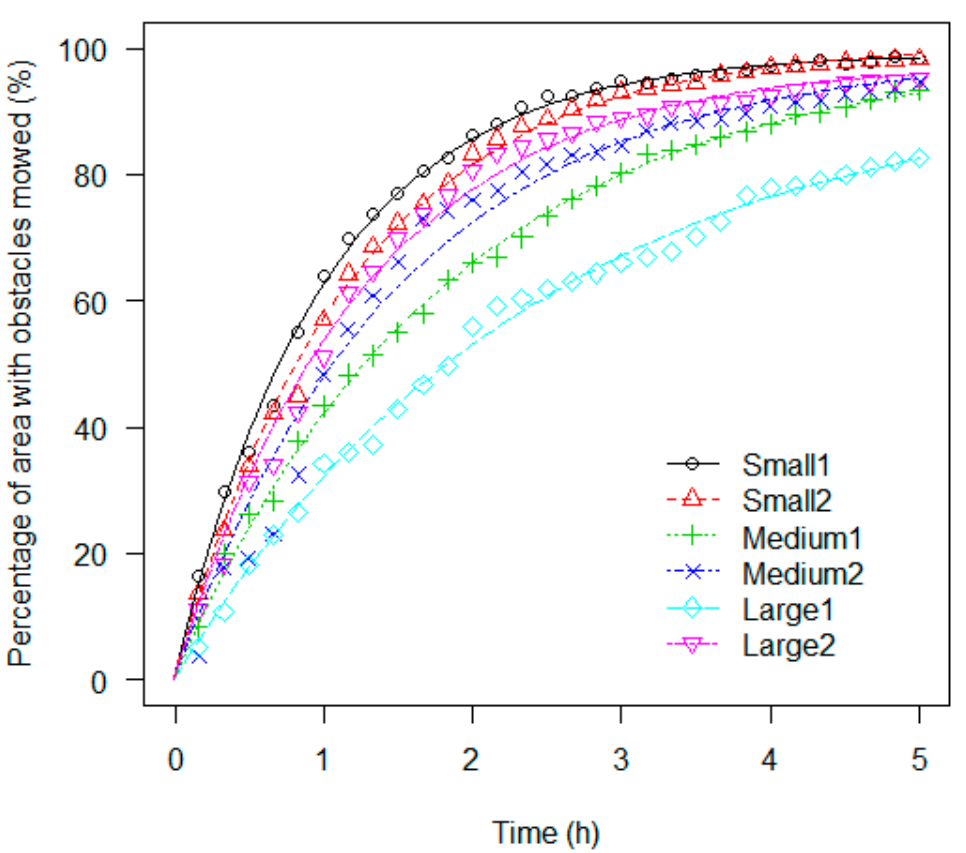
Figure 5. Fitted asymptotic regression curves with average points of the percentage of area with obstacles mown as a function of time (h) and autonomous mower type on Site B.